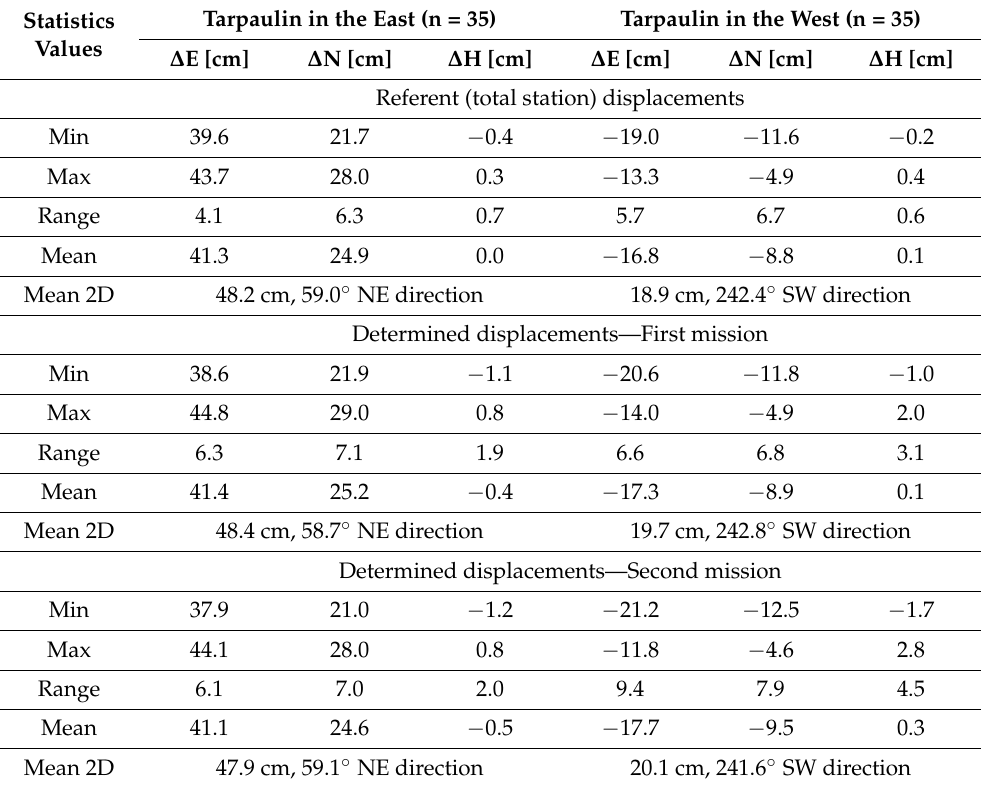
Figure 11. Displacement map of simulated landslide ( a ) and residuals in the second mission ( b ). Table 5. The statistics of the determined (proposed data processing method) and the referent (total station) displacements vector values for each tarpaulin in both